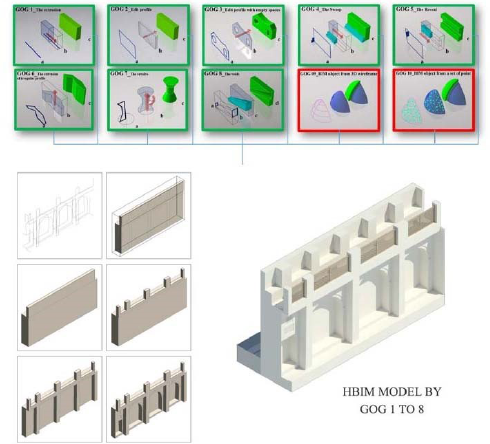
Figure 4. The first step based on the first eight GOGs (From the simple extrusion to the volumetric subtraction) allows creating complex heritage elements within Autodesk Revit.